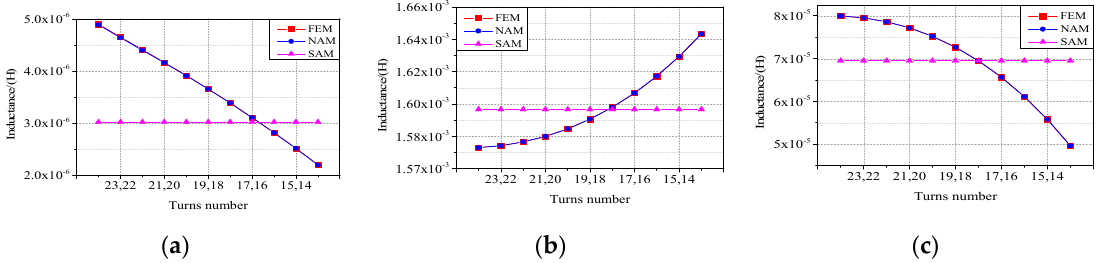
( c ) Figure 8. The flux density distributions when there are two turns shorted in layer 2: ( a ) no. 13, 14; ( b ) no. 18, 19; ( c ) no. 23, 24. Fault part Healthy part ( c ) Figure 9. The flux density distributions when different numbers of turns are shorted in layer 2: ( a ) two turns shorted; ( b ) six turns shorted; ( c ) 10 turns shorted. When the fault occurs on the same layer, the inductances of the faulty coil are shown in Figures 10–12. Figure 10 analyzes the inductances of fault coil when there are two turns shorted in layer 2. Figure 11 describes the variation of the inductances in the faulty coil when there are six turns shorted in layer 2. And the inductances of fault coil, when there are 10 turns shorted in layer 2, are presented in Figure 12. It can be seen from Figures 10–12 that, as the fault position changes from the bottom of the slot to the slot opening, the self-inductance of the faulty part gradually decreases while the self-inductance of the healthy part tends to increase, and the mutual inductance between the faulty and healthy parts gradually decreases. The comparisons among Figures 10–12 reveals that, as the number of the shorted turns increased, the self-inductance of the faulty part is increased while the